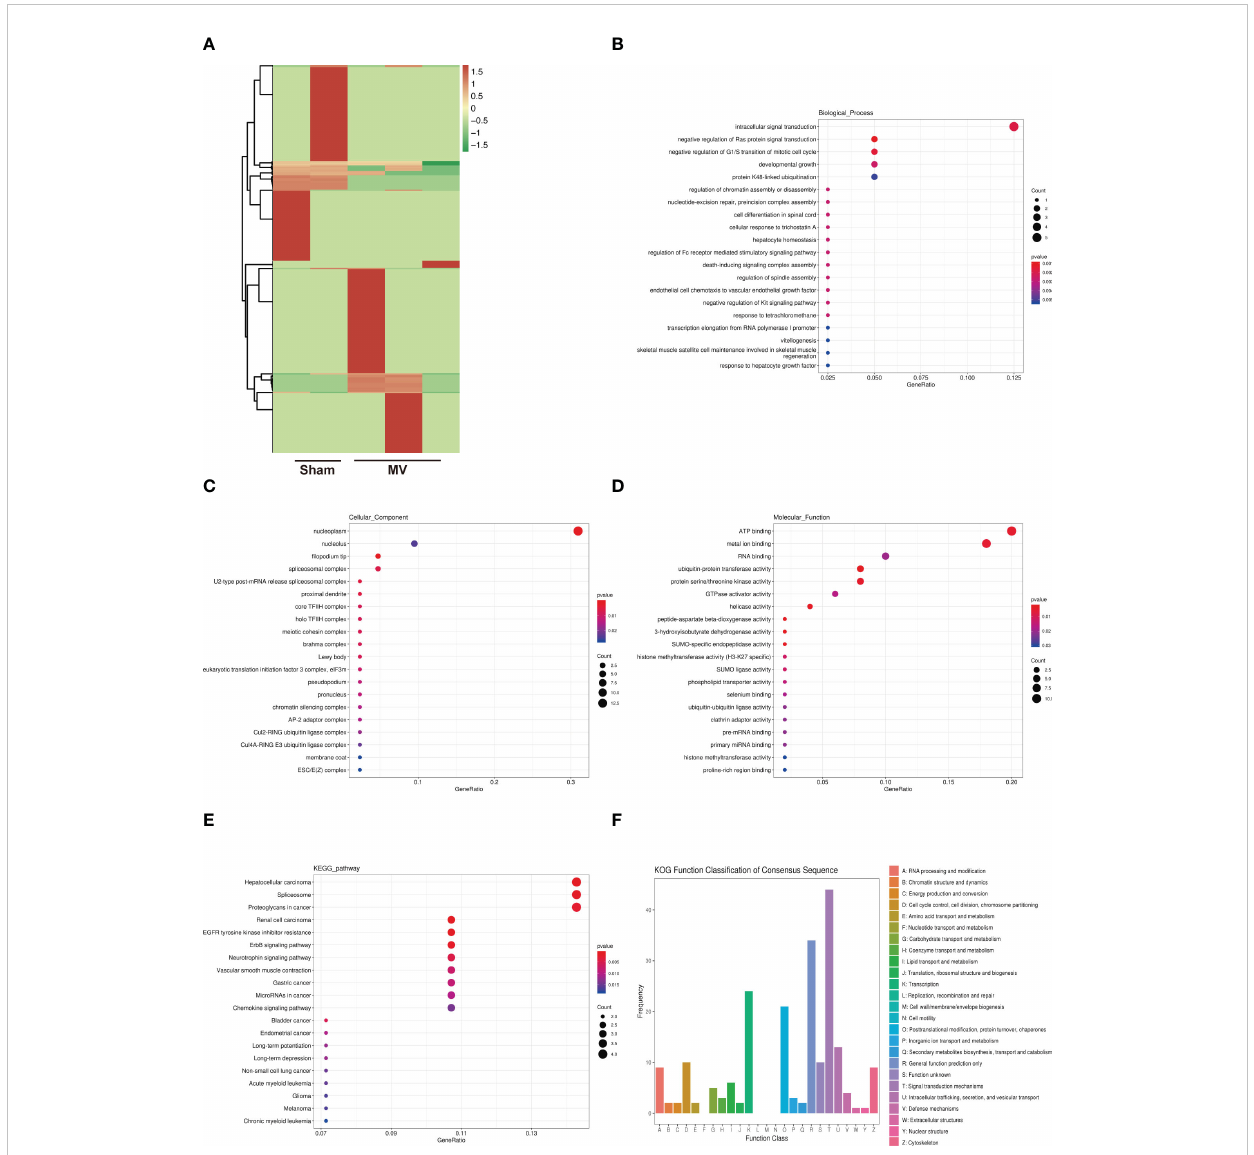
FIGURE 3 Heatmap of circRNA expression and Enrichment Analysis of differentially expressed circRNA-targeted mRNA (A) . heatmap differentially abundant circRNA in the BALF-EVs isolated from Sham and MV mice. (B-D) . Target genes of differentially expressed circRNA as determined by GO annotation. (E) . KEGG pathway analysis of differentially expressed circRNA-targeted mRNA. (F) . KOG functional classi fi cation of differentially expressed circRNA- targeted